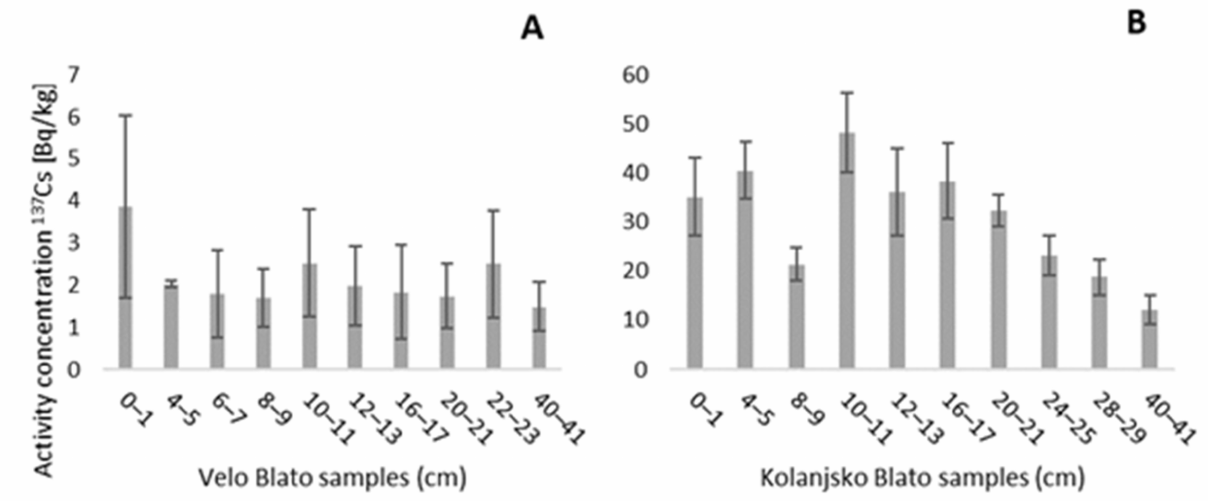
Figure 11. Activity concentrations of cesium radionuclide ( 137 Cs) in sediment core samples from Velo ( A ) and Kolanjsko Blato ( B